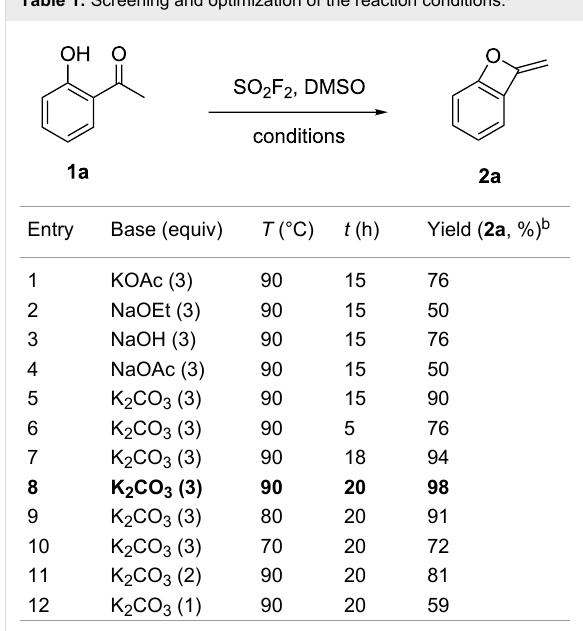
Table 1: Screening and optimization of the reaction conditions.